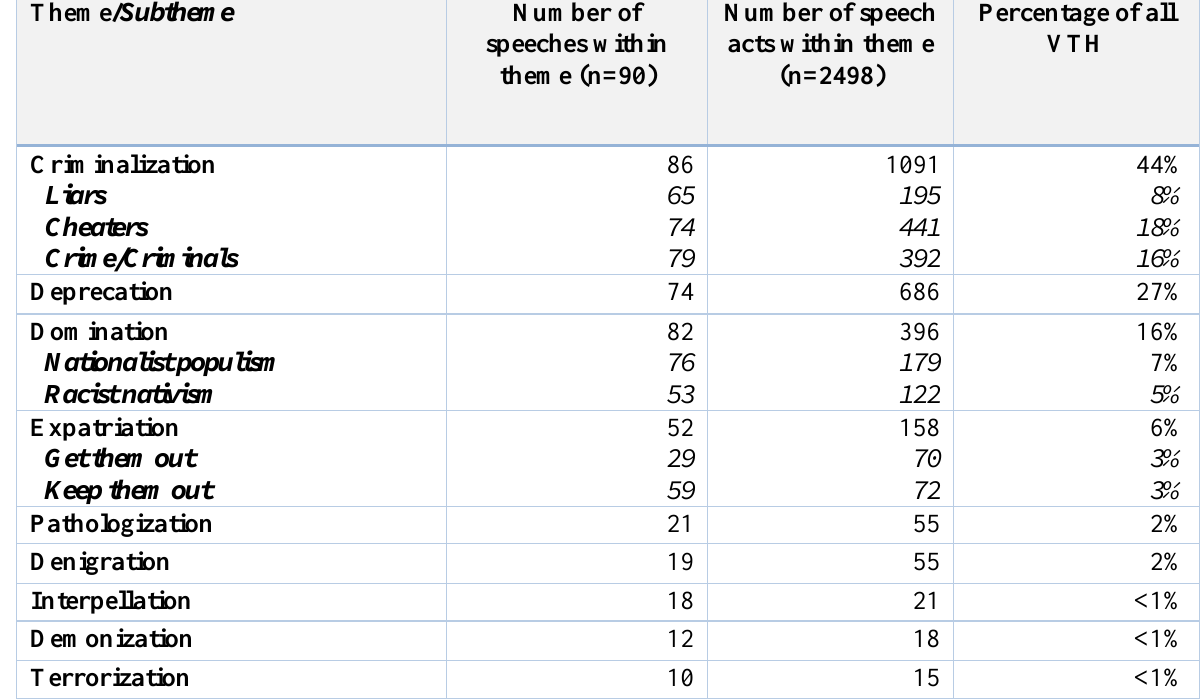
Table 1: Trump’s Verbal -Textual Hostility